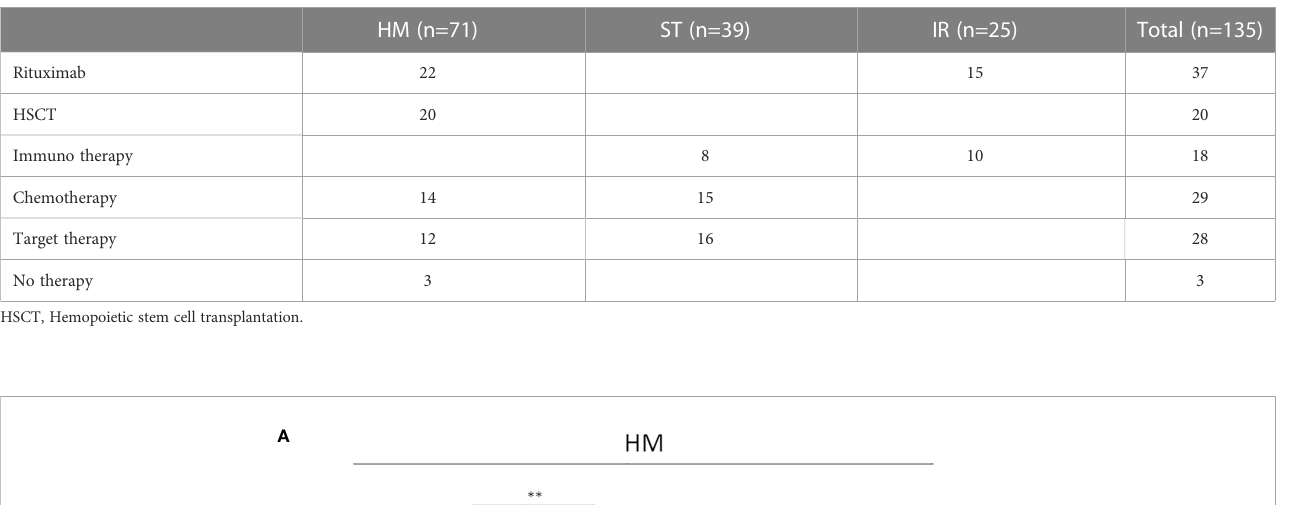
TABLE 3 Treatments.